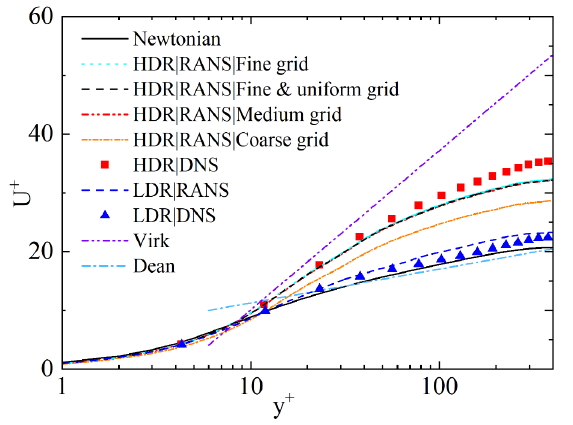
Figure 2. Comparison of U + between the current work and the DNS data. The Dean curve represents the theoretical velocity of the Newtonian fluid. Virk is the fluid velocity with the maximum theoretical drag reduction.